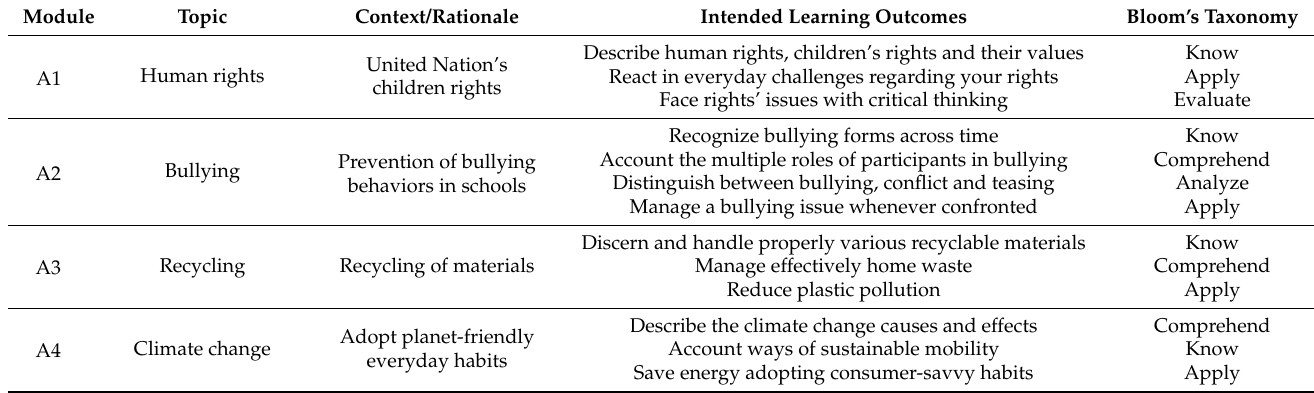
Table 1. Intended learning outcomes of playful e-learning